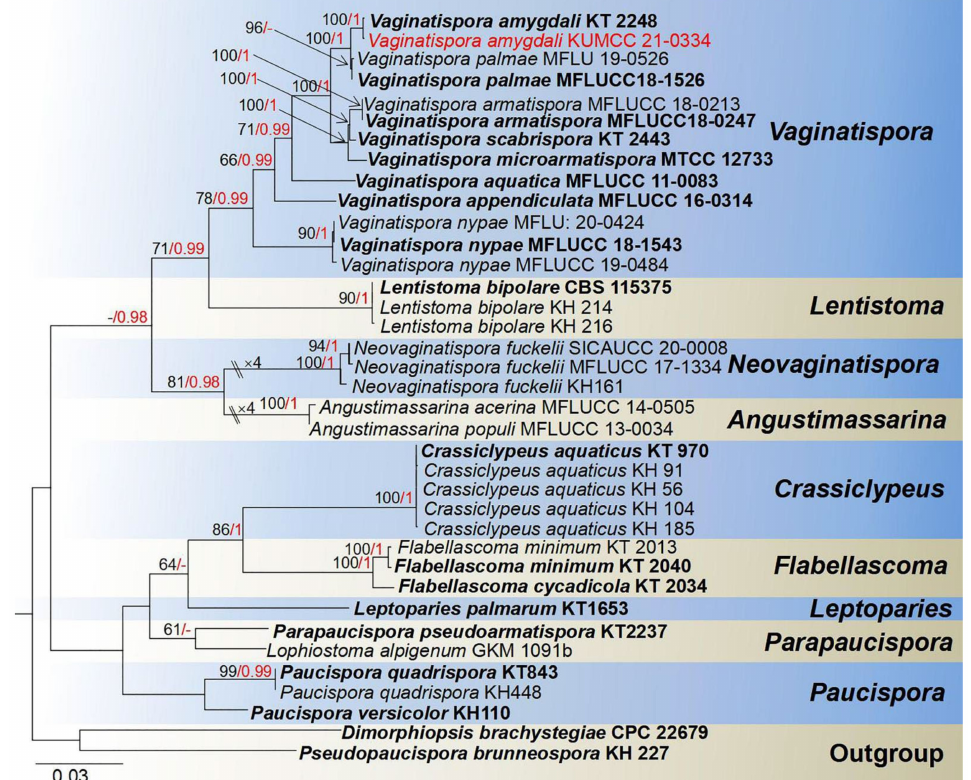
Figure 1. Phylogram generated from Maximum likelihood analysis based on a combined SSU, LSU, rpb2 , and ITS sequence datasets. Related sequences were taken from Devadatha et al. and Hyde et al. [57,60]. The 37 strains are included in the combined gene analyses’ 3621 total characters, including gaps (SSU: 1–1057 bp, LSU: 1058–1924 bp, rpb2 : 1925–2959 bp, ITS: 2960–3621 bp). Tree topology of the ML analysis was similar to the BI. The matrix had distinct alignment patterns, with the final ML optimization likelihood value of − 14,834.894356 (ln). All free model parameters were estimated by RAxML model, with 279 distinct alignment patterns and 40.11% undetermined charac- ters or gaps. Estimated base frequencies were as follows: A = 0.256878, C = 0.226899, G = 0.272251, T = 0.243972, with substitution rates AC = 1.942312, AG = 4.354437, AT = 1.541678, CG = 1.334482, CT = 9.764709, AND GT = 1.000000. The gamma distribution shape parameter alpha = 0.712530, and the Tree-Length = 1.210702. The final average standard deviation of split frequencies at the end of total MCMC generations calculated as 0.009954 in BI analysis. The species determined in this study are indicated in red. Bootstrap values greater than 60% (ML, left) and Bayesian posterior probabilities (BI, right) greater than 0.95 are given at the nodes; hyphens (-) represent support values less than 60% in ML/0.95 in